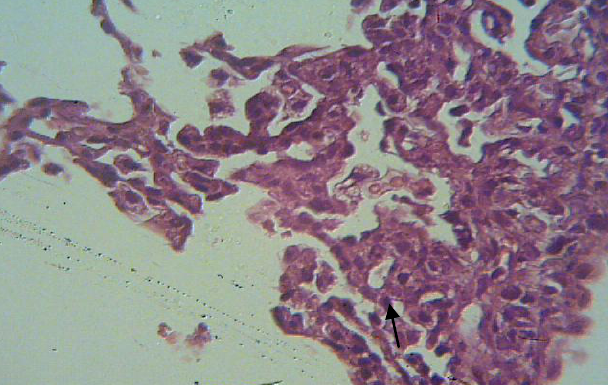
Fig 1: Histological section of the mice lung at 2 weeks post immunization with HK-CA+FCA showed more mononuclear cells infiltration in the interstesial tissue( ).H&E stain(400X).